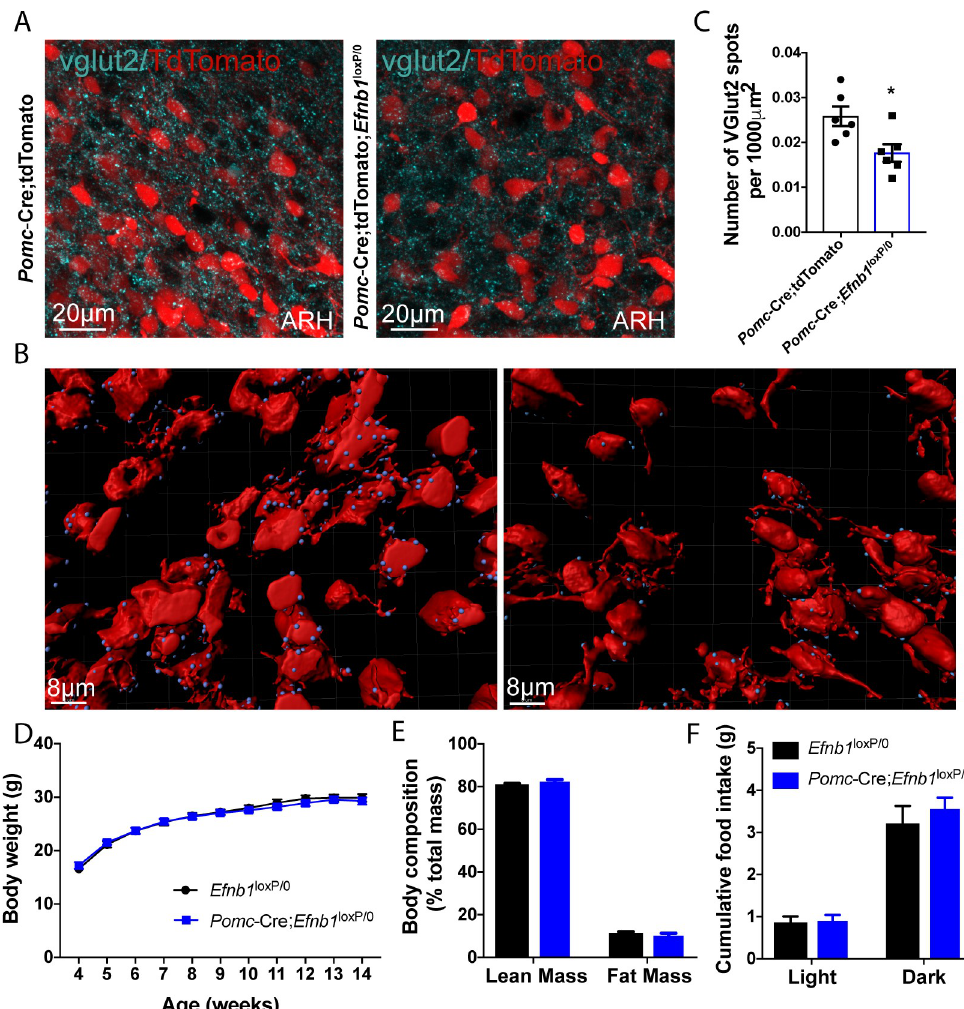
Fig 3. Lack of Efnb1 in POMC-expressing progenitors decreases the amount of glutamatergic inputs into these neurons. (A) High magnification of vGLUT2-positive terminals into POMC-expressing progenitors (red) in Pomc -Cre; tdTomato control and Pomc -Cre; Efnb1 loxP/0 ;tdTomato mutant male mice. (B) Example of 3D reconstruction (IMARIS) and quantification (C) of vGLUT2-positive inputs (blue) in direct apposition with Pomc -Cre;tdTomato neurons (red) ( n = 3/group, 2 sections/animal). (D) Post-weaning growth curve of Efnb1 loxP/0 and Pomc -Cre; Efnb1 loxP/0 male mice ( n = 14–15/group). (E) Body composition of 16–18-week-old male mice ( n = 9–10/group). (F) Cumulative food intake of 13–14-week-old Efnb1 loxP/0 and Efnb1 loxP/0 ;Pomc -Cre male mice ( n = 9–12/group). Data are shown ± SEM. Statistical significance was determined using 2-way ANOVA (D–F) and 2-tailed Student t test (C). � P � 0.05 versus Pomc -Cre; tdTomato (C). The underlying data are provided in S1 Data. ANOVA, analysis of variance; ARH, arcuate nucleus of the hypothalamus; POMC, proopiomelanocortin; SEM, standard error of the